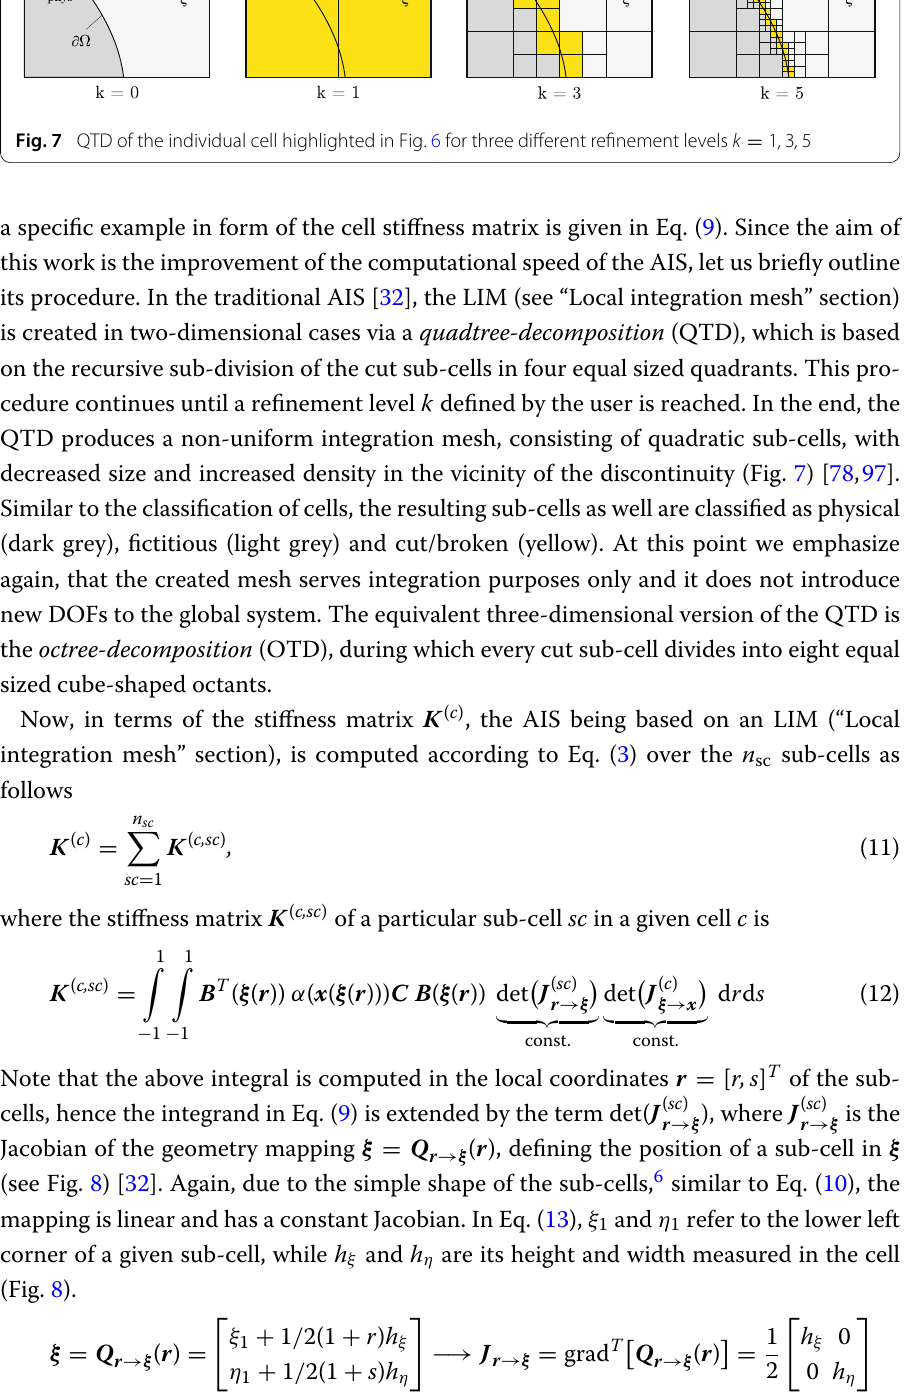
Fig. 7 QTD of the individual cell highlighted in Fig. 6 for three different refinement levels k = 1 , 3 , 5